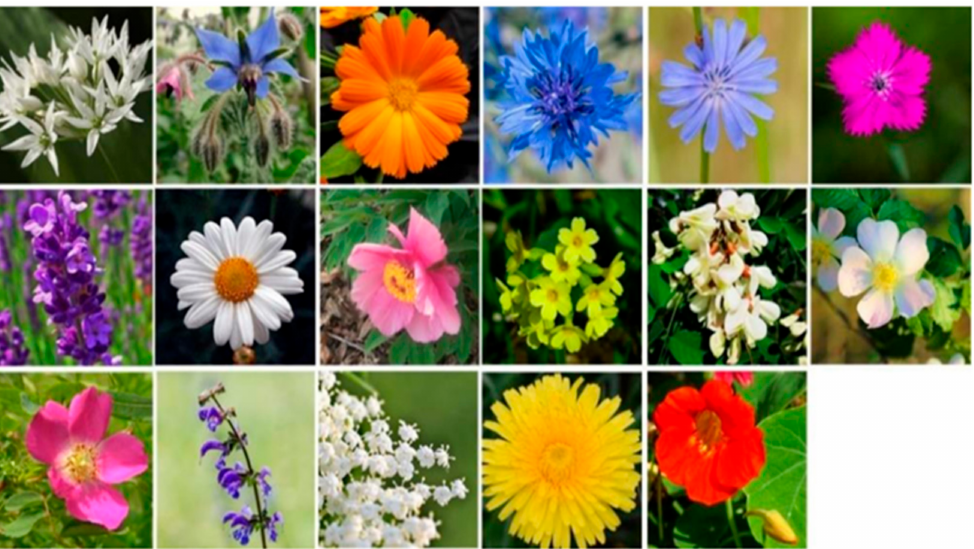
Figure 1. Images of seventeen edible flowers selected by Demasi et al. [2]. From left to right, first line is as follows: Allium ursinum L., Borago officinalis L., Calendula officinalis L., Centaurea cyanus L., Cichorium intybus L., Dianthus carthusianorum L.; second line is as follows: Lavandula angustifolia Mill., Leucanthemum vulgare (Vaill.) Lam., Paeonia officinalis L., Primula veris L., Robinia pseudoacacia L., Rosa canina L.; third line is as follows: Rosa pendulina L., Salvia pratensis L., Sambucus nigra L., Taraxacum officinale Weber, Tropaeolum majus